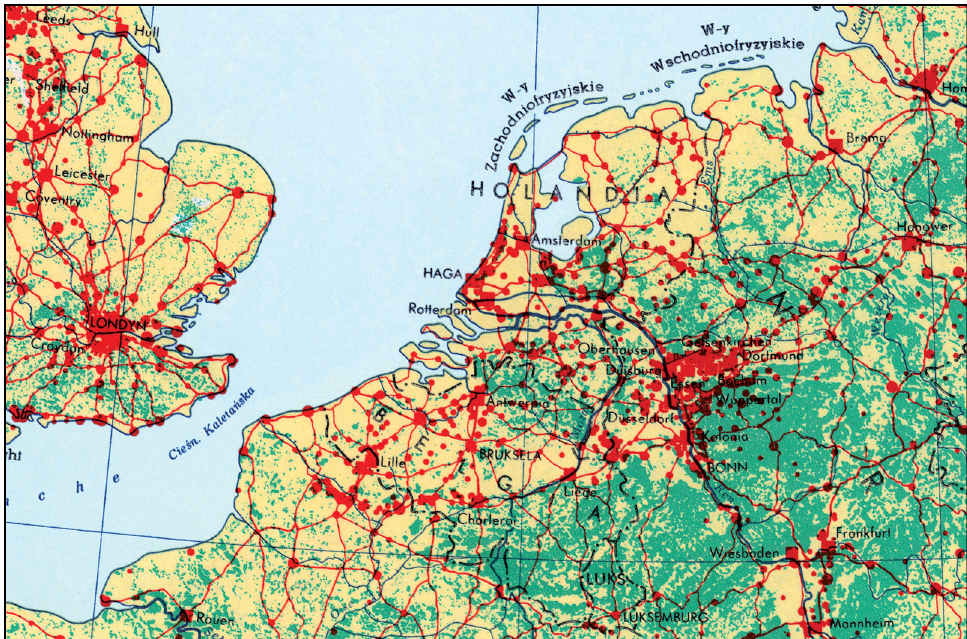
Fig. 4. Settlement states and road network on the landscape map by F. Uhorczak (a part of the map of Western Europe, scale 1:6,000,000 from volume III of “Universal